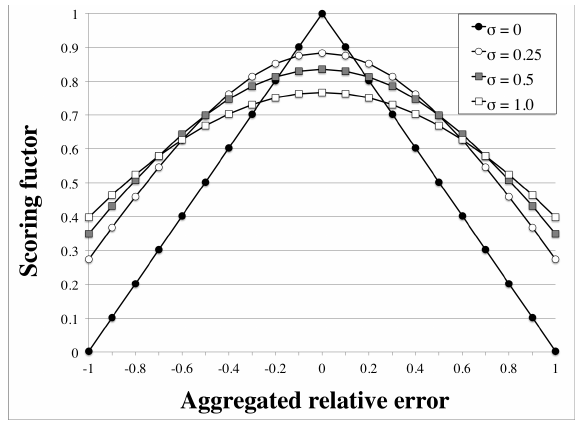
Fig. 2. A CRPS scoring mechanism for different